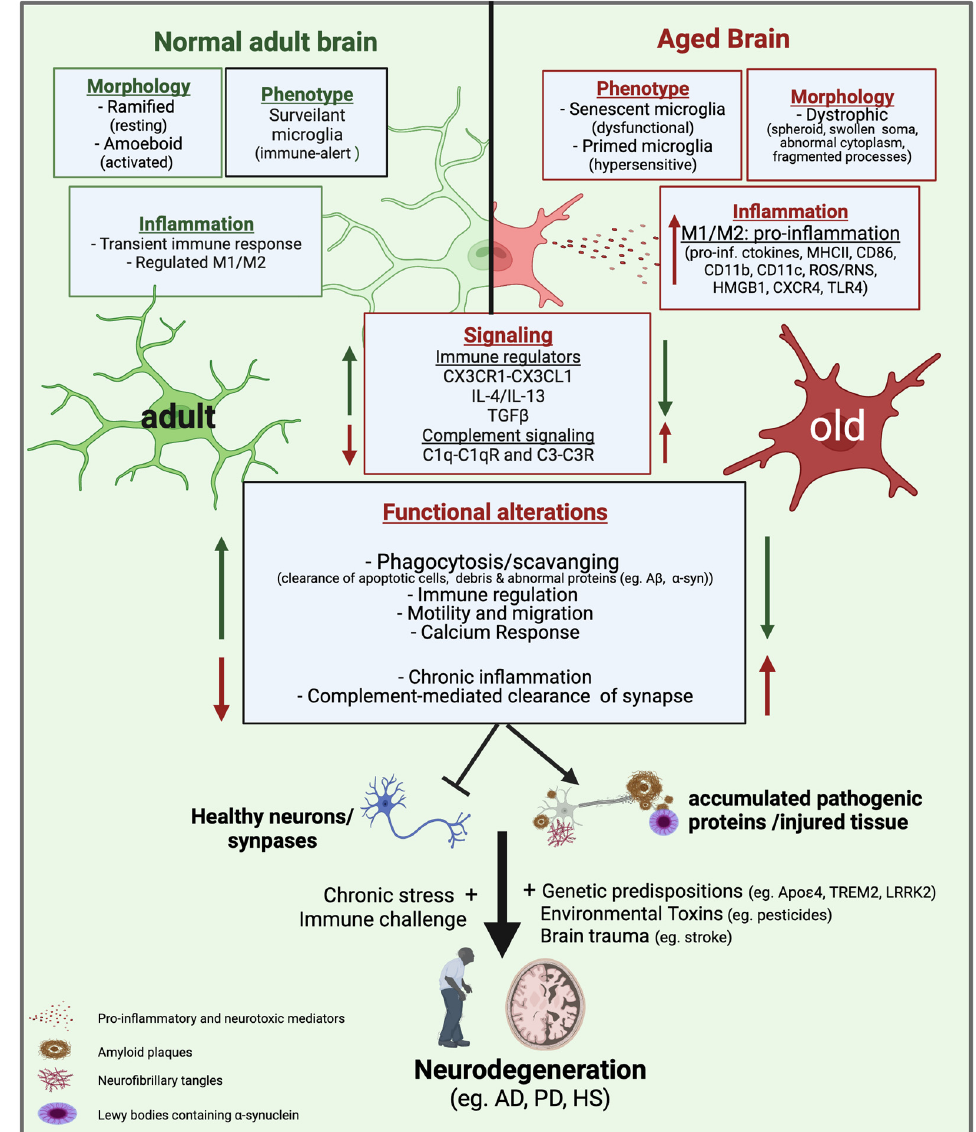
Figure 2. Age-dependent microglial changes implicated in neurodegenerative diseases. During